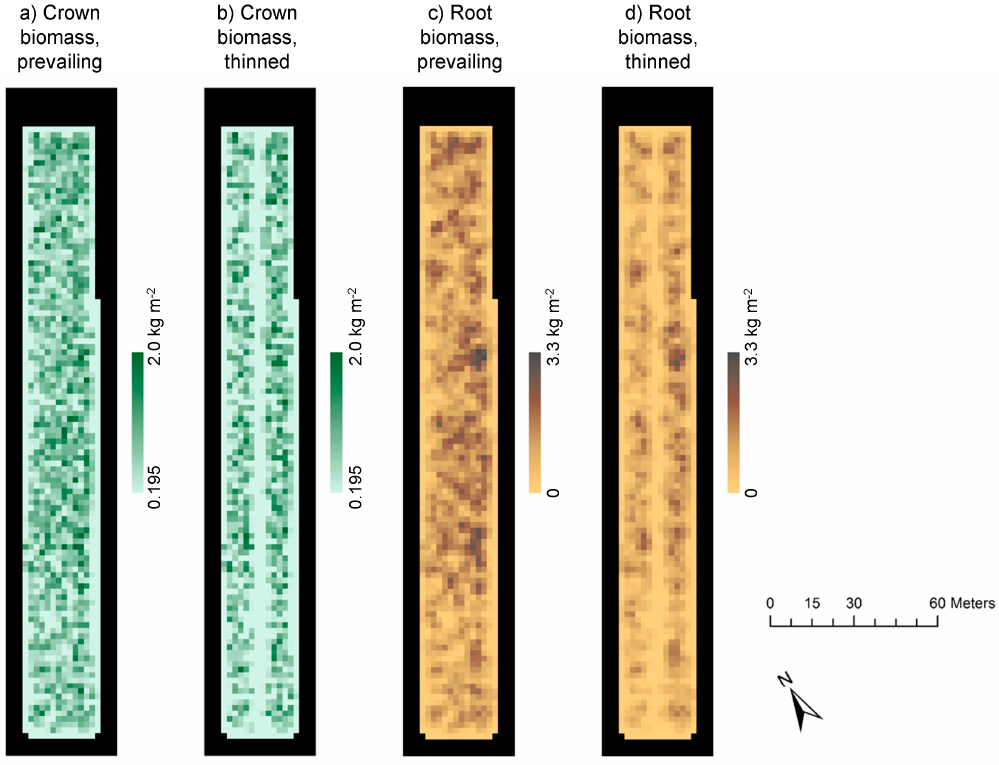
Figure 2. Crown ( a , b ) and root ( c , d ) biomasses with prevailing and thinned tree stand in Sattasuo (for biomass calculations, see Section 2.4). In figures ( a – b ), uniform understory biomass is included in every cell (0.195 kg m − 2 ).